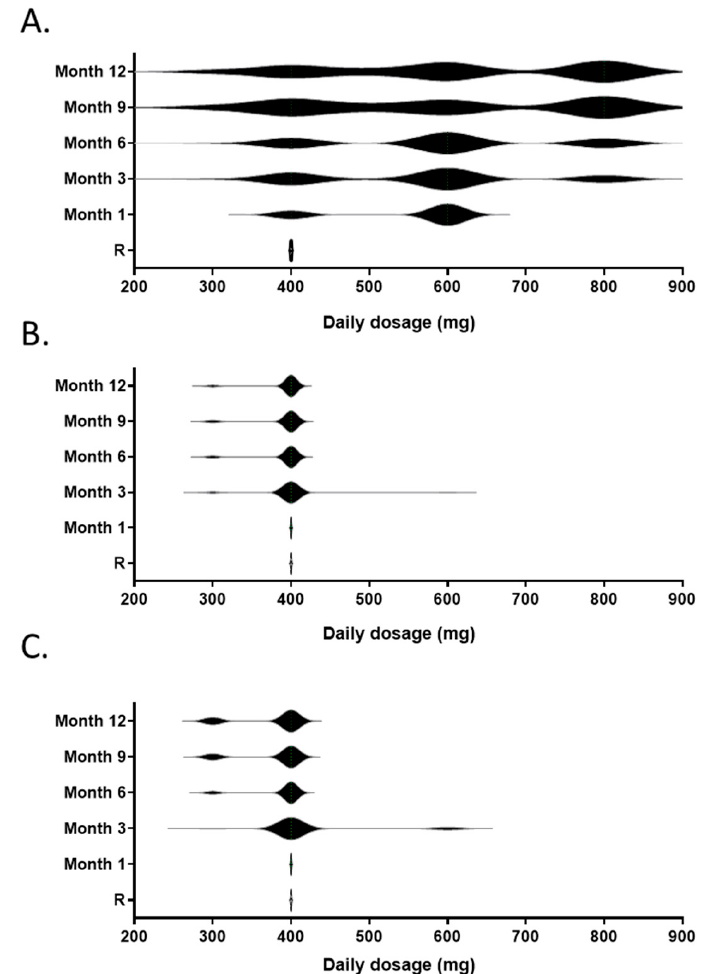
Figure 3. Imatinib daily dose over the 12-month adaptation period for the patients included in the TDM arm ( A ), the control arm ( B ) and the observational arm ( C ). The violin plots represent the distributions of individual daily doses.